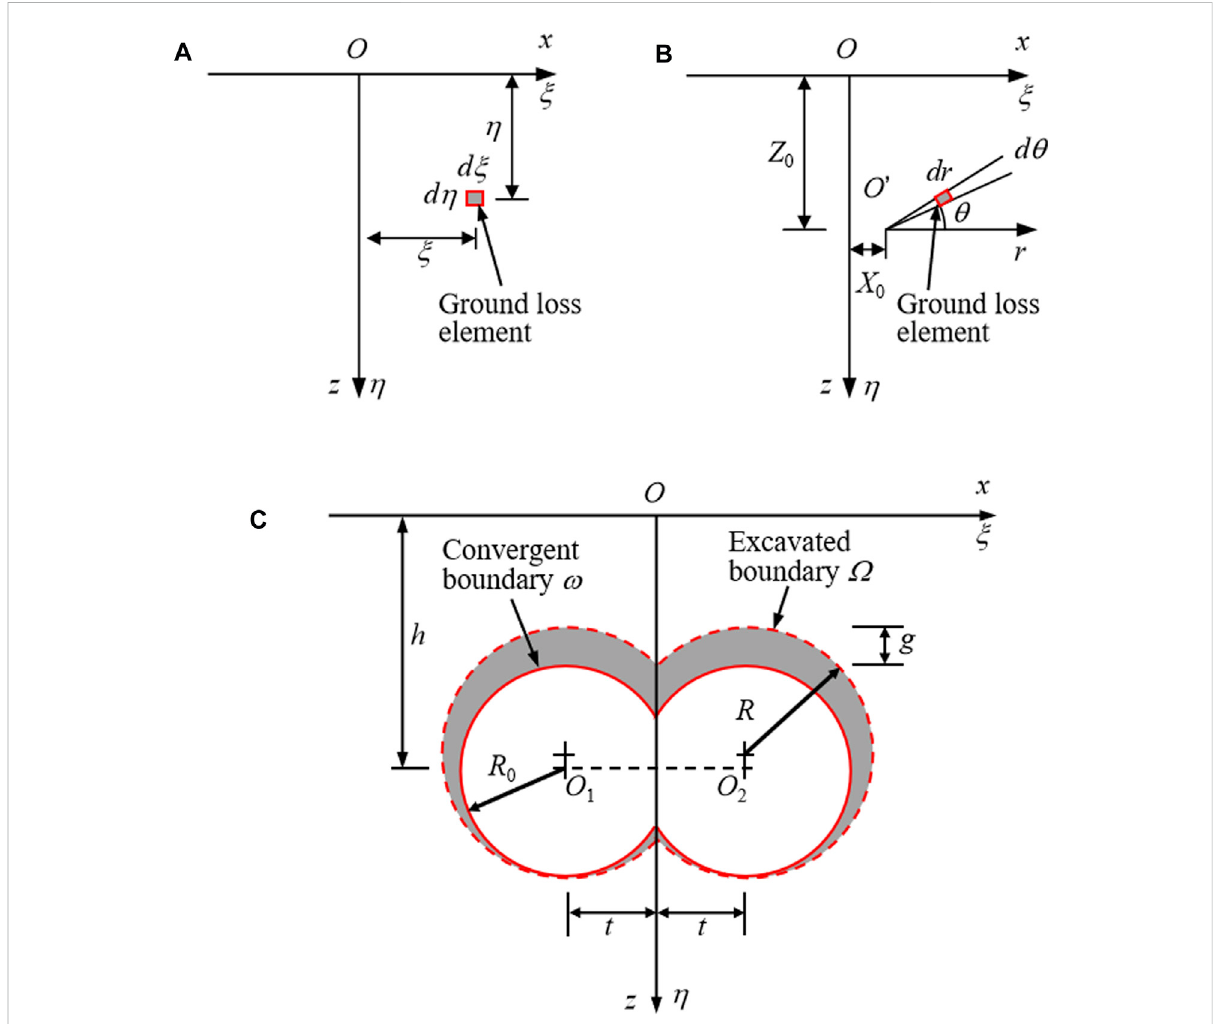
FIGURE 5 Model of DOT shield tunneling-induced soil deformation: (A) Cartesian coordinate system considering ground loss element; (B) polar coordinate system considering ground loss element; (C) Ground loss model induced by DOT shield tunnelling.